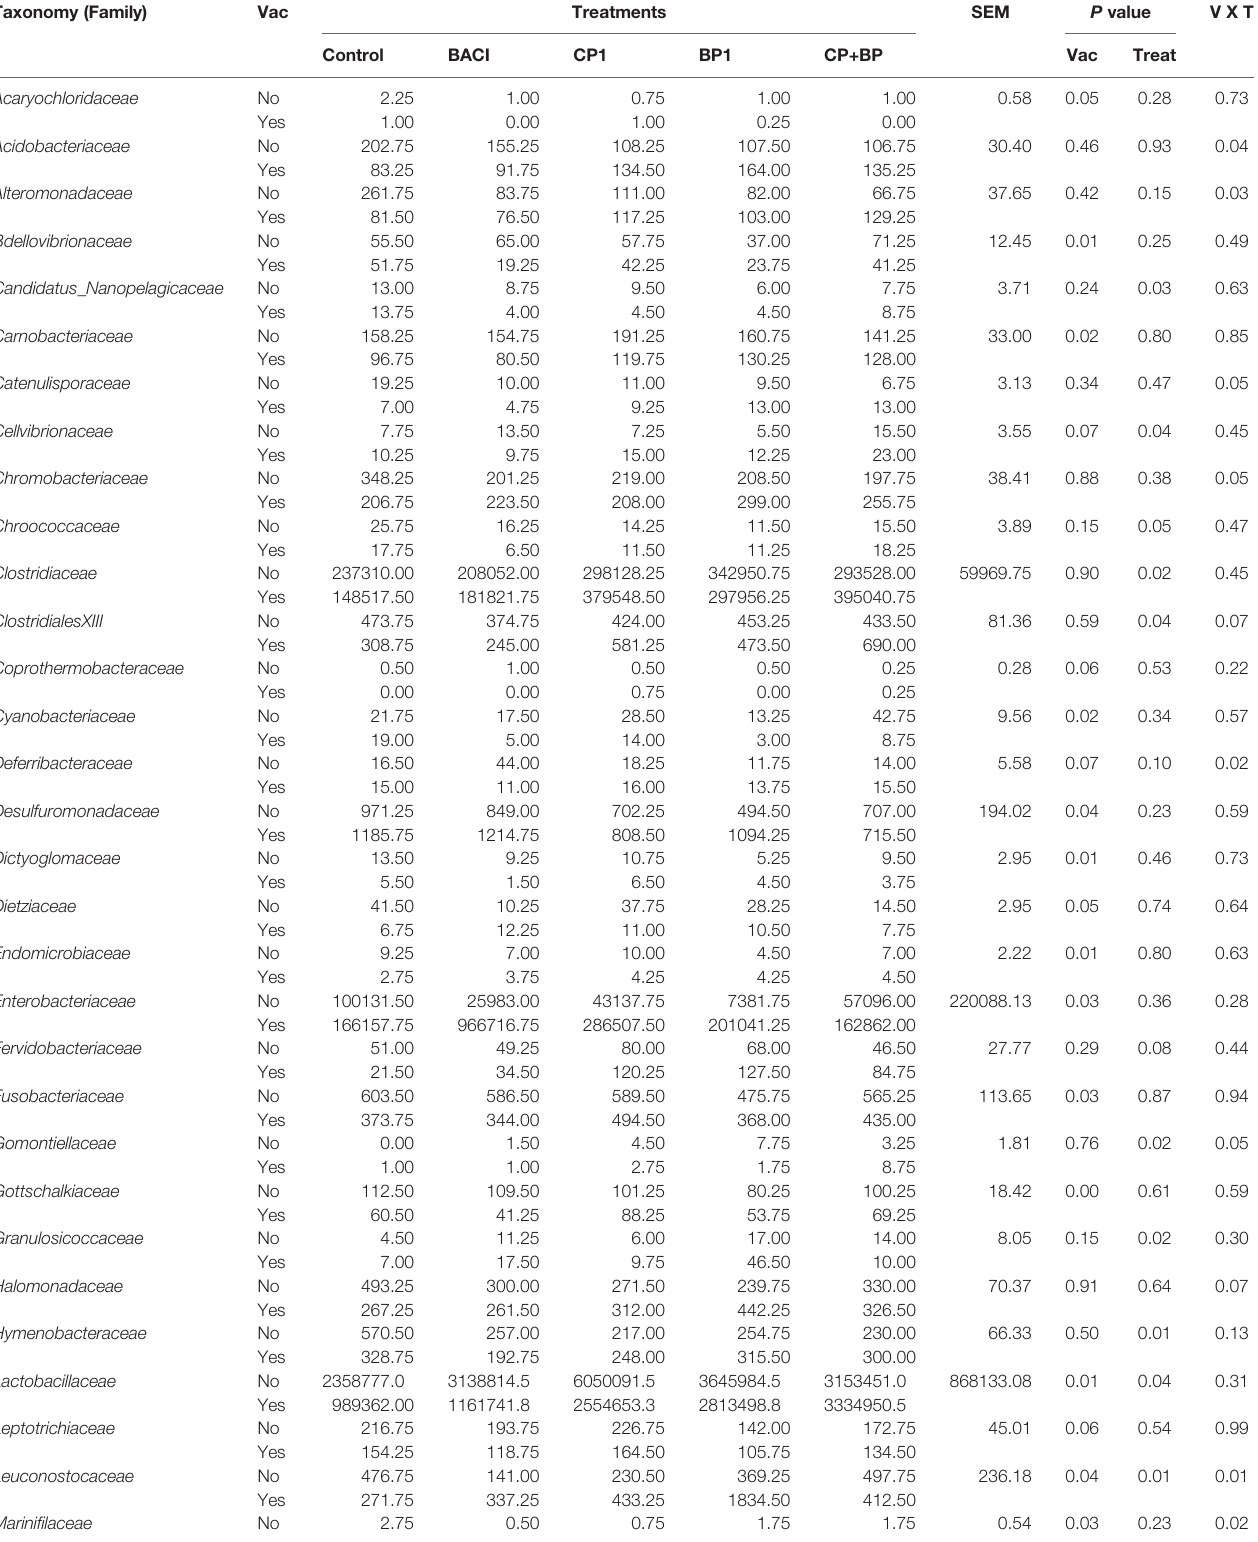
TABLE 6 | Microbial composition in the ceca digesta of 21-day-old broilers at family level signi fi cantly ( P < 0.05) affected by studied dietary treatments. Taxonomy (Family) Vac Treatments SEM V X T